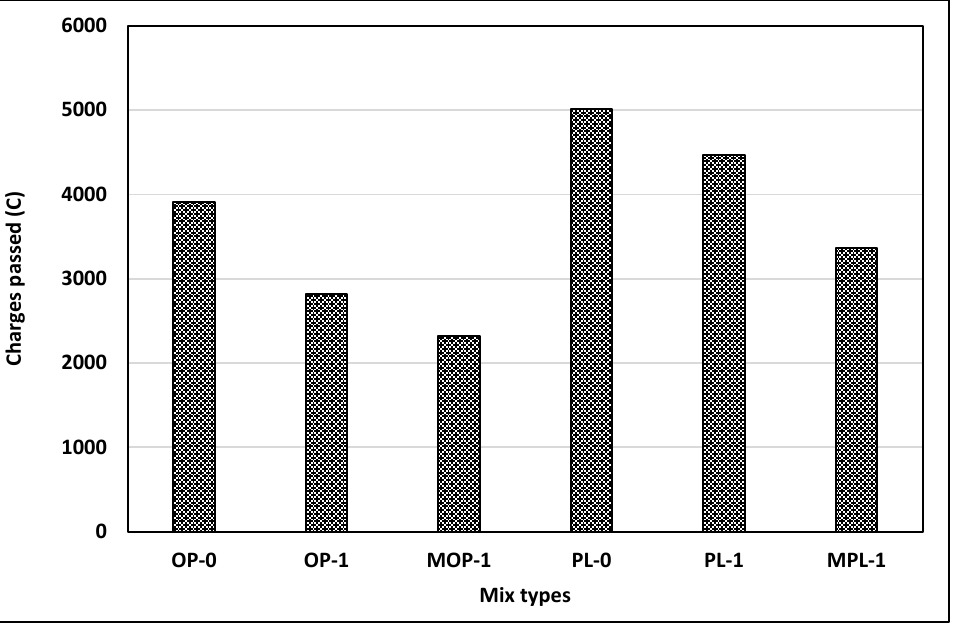
Figure 8. Results of rapid chloride penetration test (RCPT).